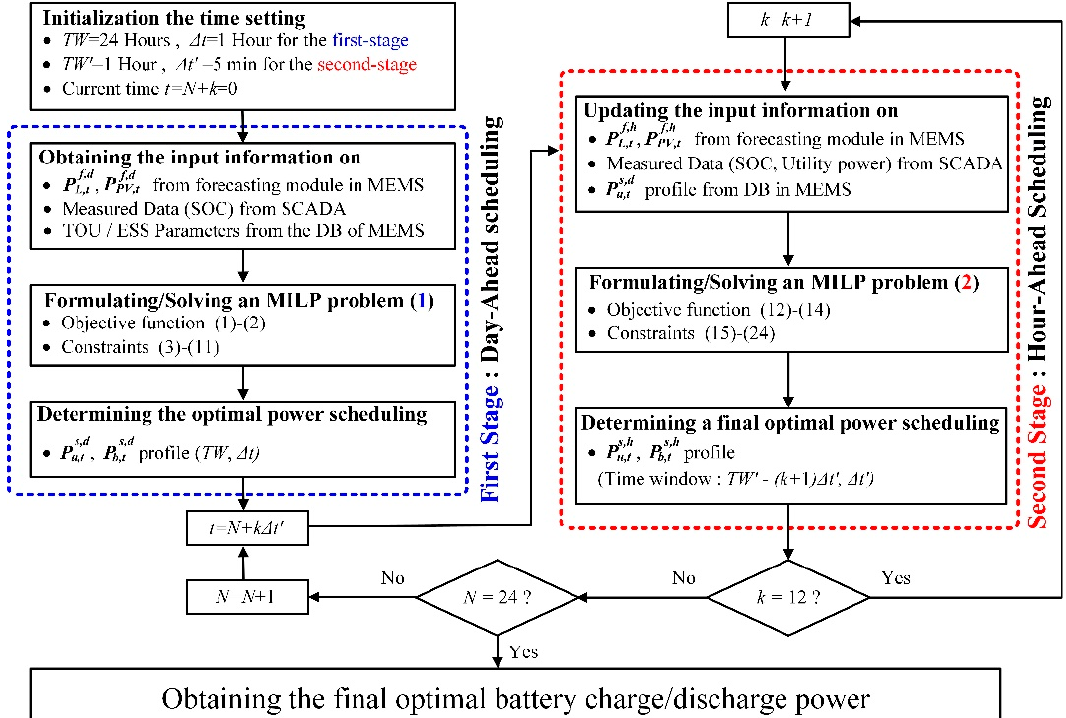
Figure 4. Flowchart of the proposed two-stage scheduling for one day.